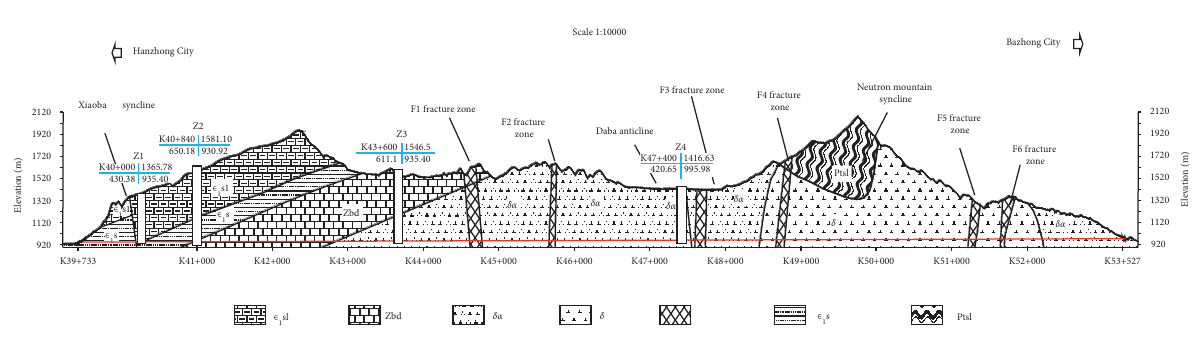
Figure 1: Location of the Micangshan tunnel.